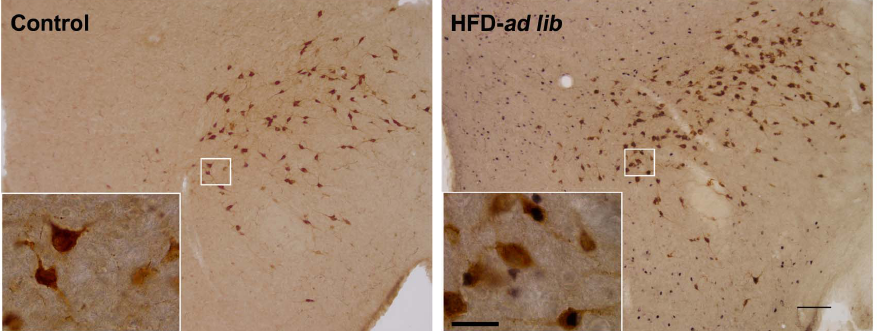
Figure 5. Acute HFD activates c-Fos in orexin-IR neurons of the LHA. Panels show representative photomicrographs of brain sections subjected to double immunohistochemistry using anti-orexin (brown staining) and anti-c-Fos (purple/black staining) antibodies. Left and right panels show images from mice of control and HFD- ad lib groups, respectively. Inserts show in higher magnification the areas marked in low magnification images. Arrows point to dual-labeled cells. Scale bars, 200 m m (low magnification), 20 m m (high magnification).